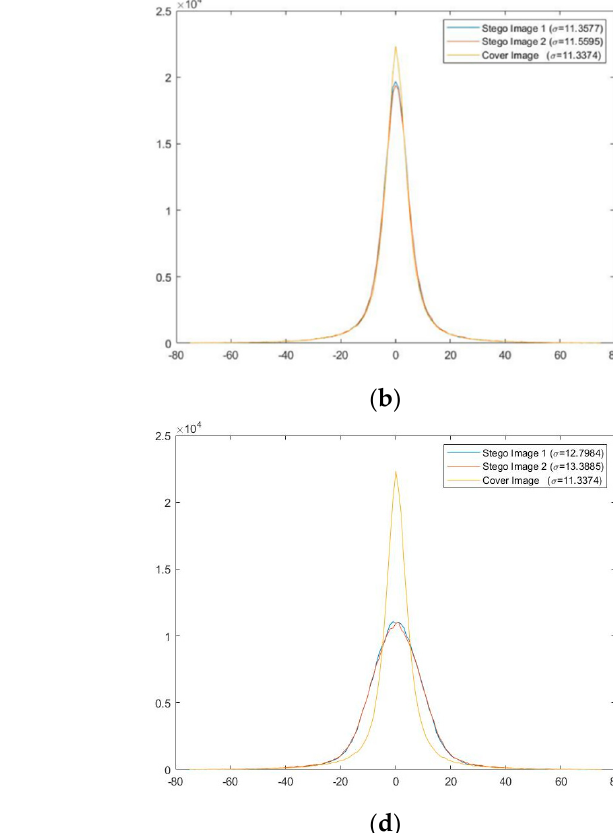
Figure 10. Comparisons of histogram analysis for n = 3 in grayscale Lena image.